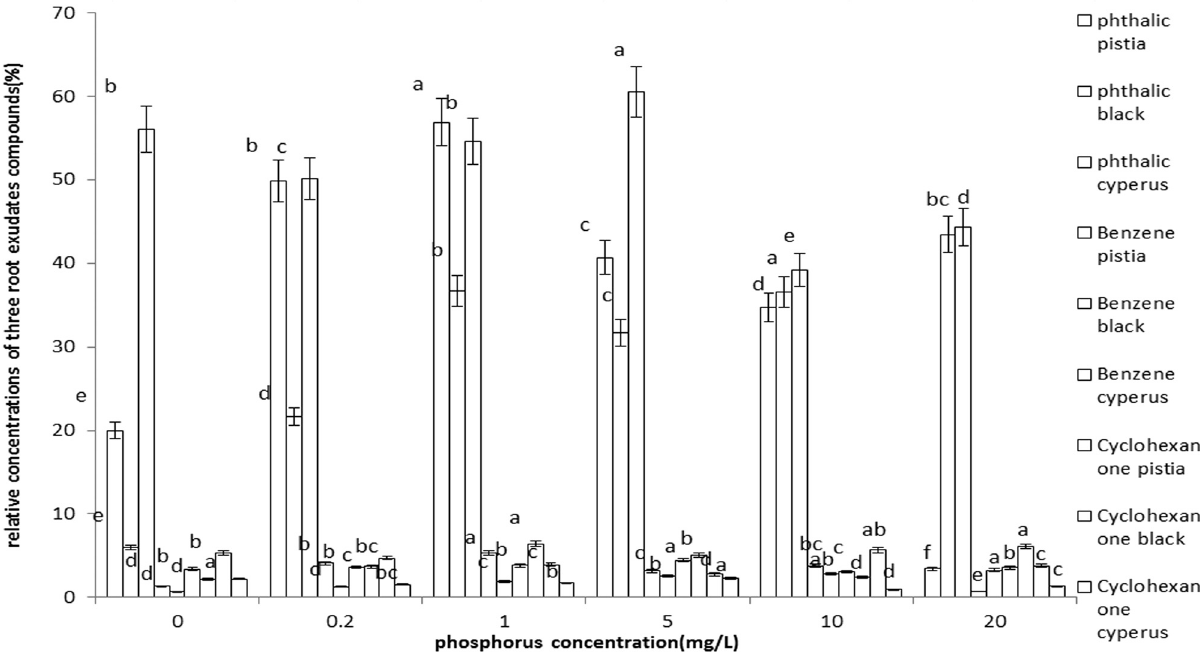
Figure 1: Di ff erent relative concentrations of the three root exudates compounds under phosphorus gradients stress. Note: the same letters in the fi gure indicate no signi fi cant di ff erence ( P > 0.05 ) , while di ff erent letters indicate signi fi cant di ff erence ( P < 0.05 )